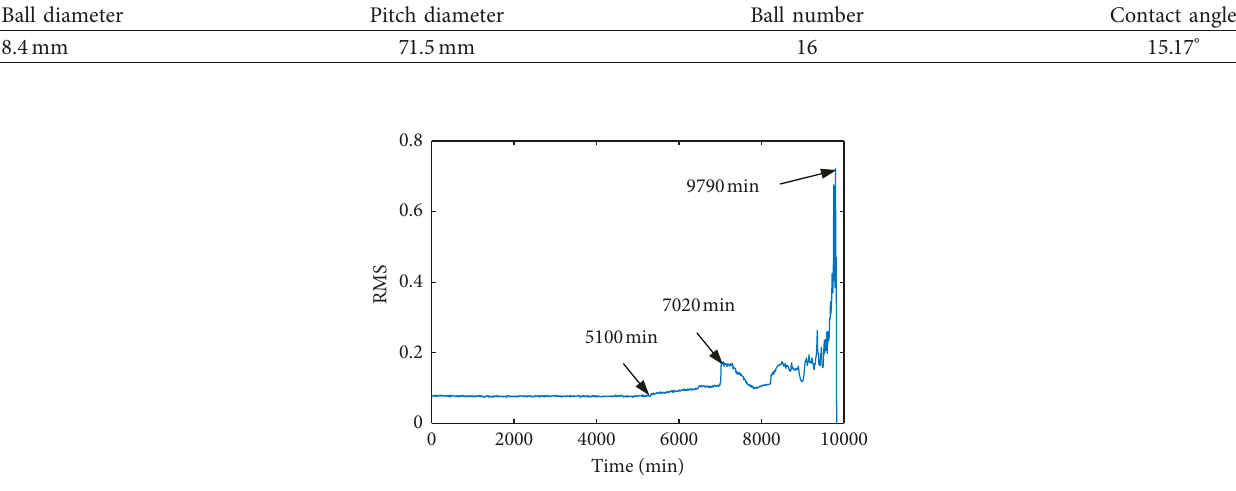
Figure 20: Bearing fault tendency chart.